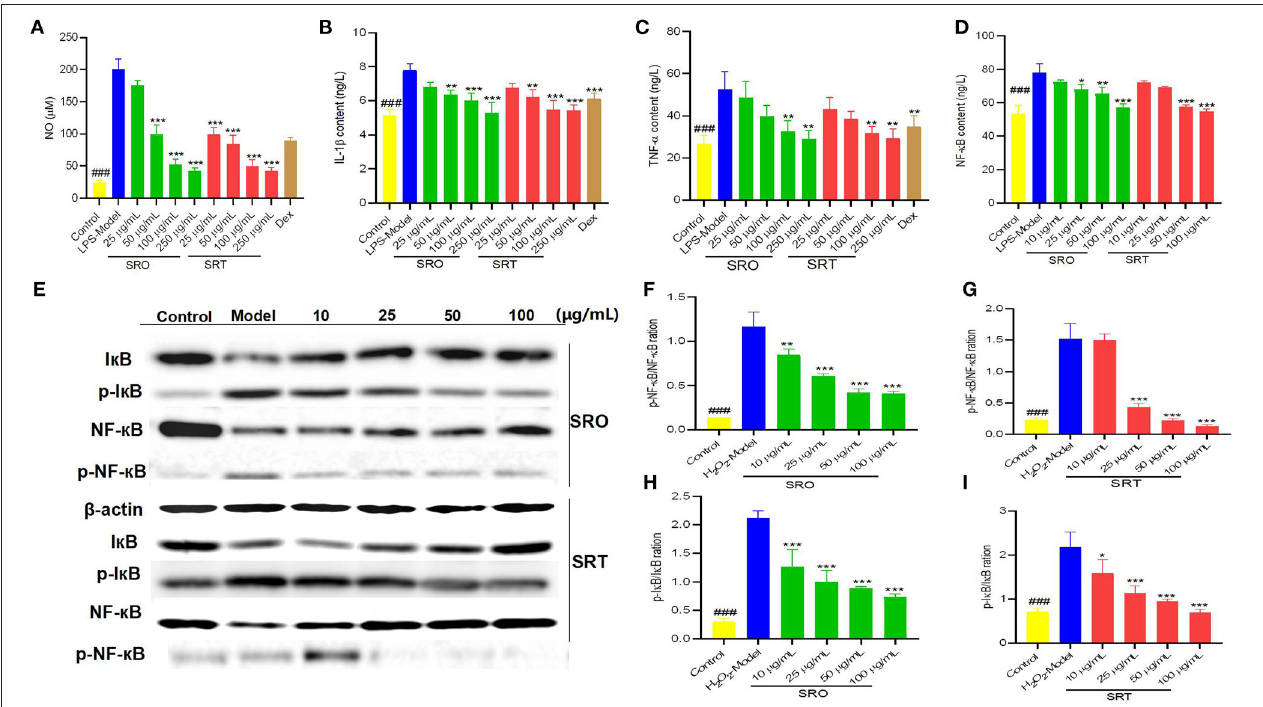
FIGURE 3 | The NO content (A) , IL-1 β content (B) , TNF- α content (C) , and NF- κ B content (D) in RAW264.7 cells induced by LPS; the western blot assay for determining the expression of I κ B and NF- κ B (E) ; the p-NF- κ B/NF- κ B ration for SRO (F) and SRT (G) ; the p-I κ B/I κ B ration for SRO (H) and SRT (I) ( ### represent the significant difference between control group and model group, p < 0.001; * p < 0.05 represent the significant difference between model group and drug-treated group; ** p < 0.01; *** p <